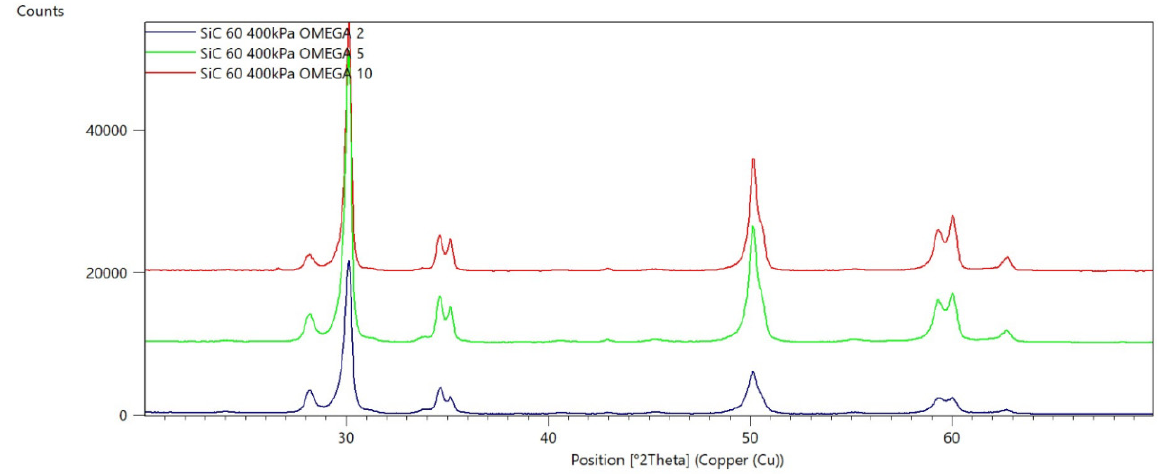
Figure 9. Diffraction patterns of the H sample (abrasive—SiC 60 μ m, pressure 400 kPa).